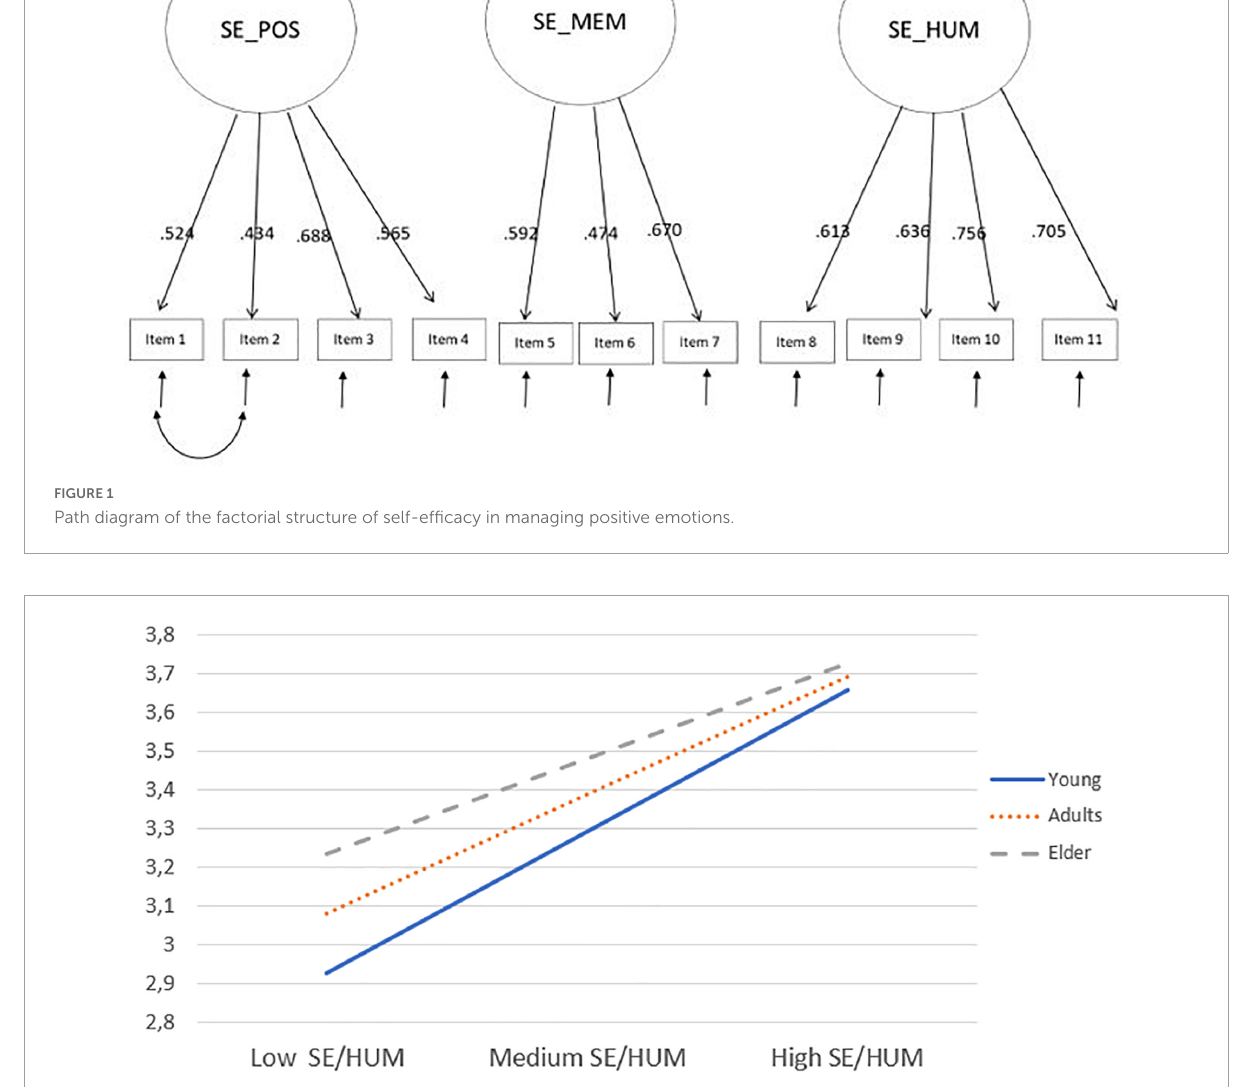
FIGURE2 Plot of the interaction of self-efficacy beliefs in using humor and age in predicting life